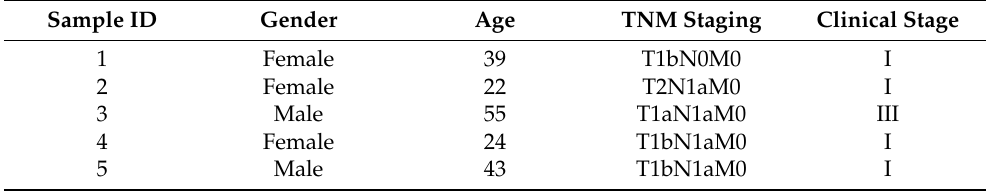
Table 1. Patients’